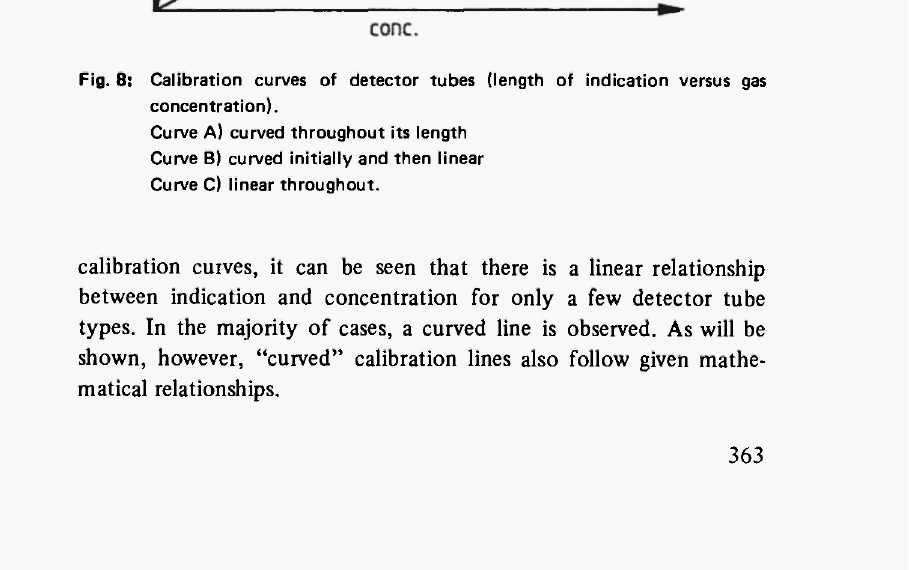
Fig. 8: Calibration curves of detector tubes (length of indication versus gas